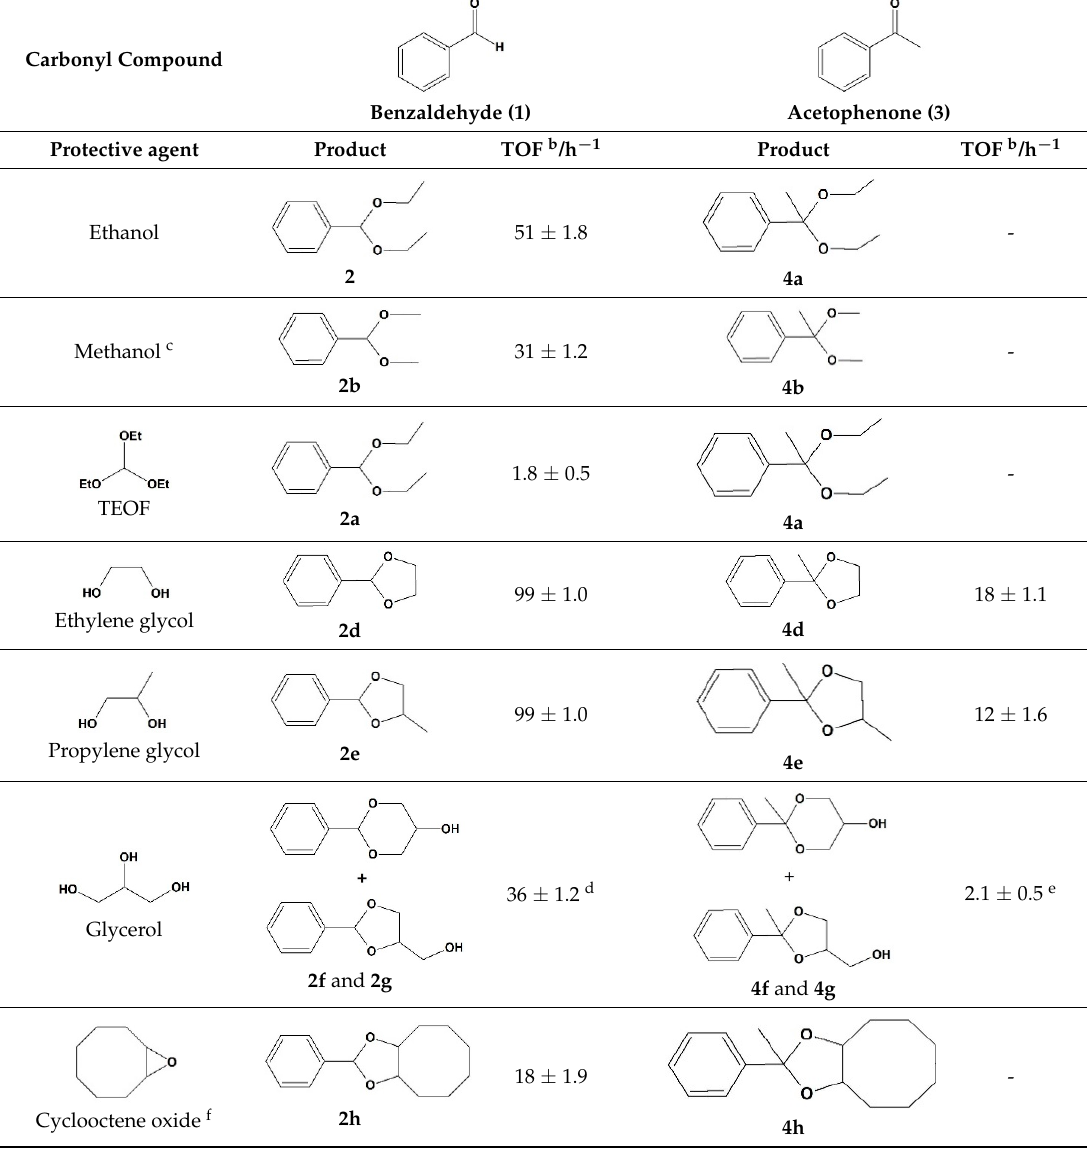
Table 4. Products from acetalization reactions of benzaldehyde ( 1 ) and acetophenone ( 2 ) catalyzed by Fe5F with different protective agents a and their TOF values.